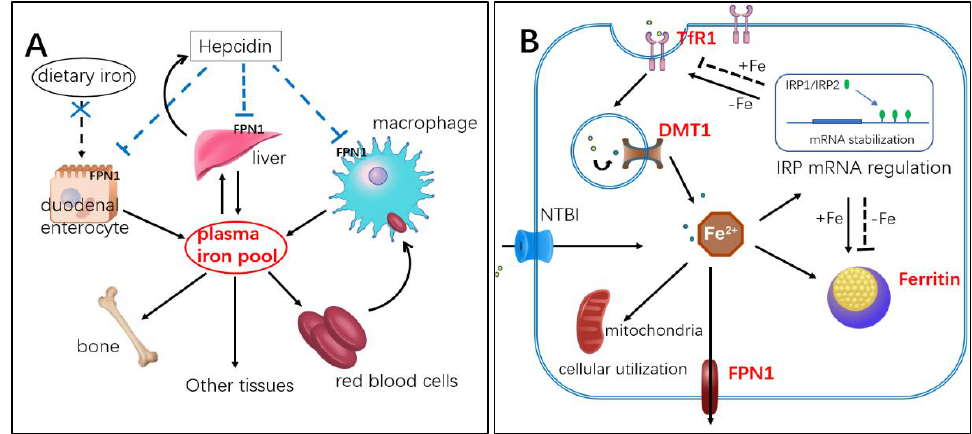
Figure 1. Schematic of iron metabolism. ( A ) Systemic iron metabolism: hepcidin is secreted by the liver, which inhibits expression of iron-releasing protein ferroportin 1 (FPN1) on membrane of intestinal epithelial cells, liver, and macrophages, thus controlling serum iron concentration. ( B ) Cellular iron metabolism: Transferrin receptor 1 (TfR1) on the surface of the cell membrane binds to iron-containing transferrin in blood and is ingested into the cell via endocytosis. Ferric iron then breaks away from the receptor and is converted to ferrous iron, then released into the cytoplasm through divalent metal transporter 1 (DMT1). Some iron in the cytoplasm is utilized biologically, some is stored after binding with ferritin, and some is excreted by FPN1. When intracellular iron content is low (-Fe), ferritin synthesis is inhibited by iron regulatory protein (IRP) regulation, while TfR1 expression is increased, and iron absorption capacity is